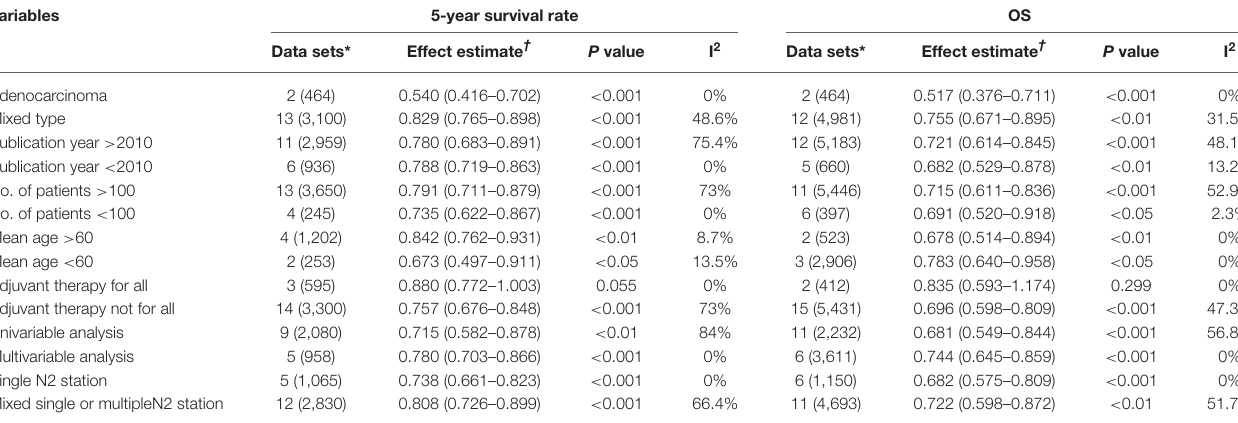
* Values in parentheses are the number of patients. † Values are hazard ratios (HRs) 95% CIs for OS; HRs below 1 favor skip N2, whereas values are odds ratio (ORs) 95% CIs for 5-year survival rate; ORs below 1 favor skip N2.